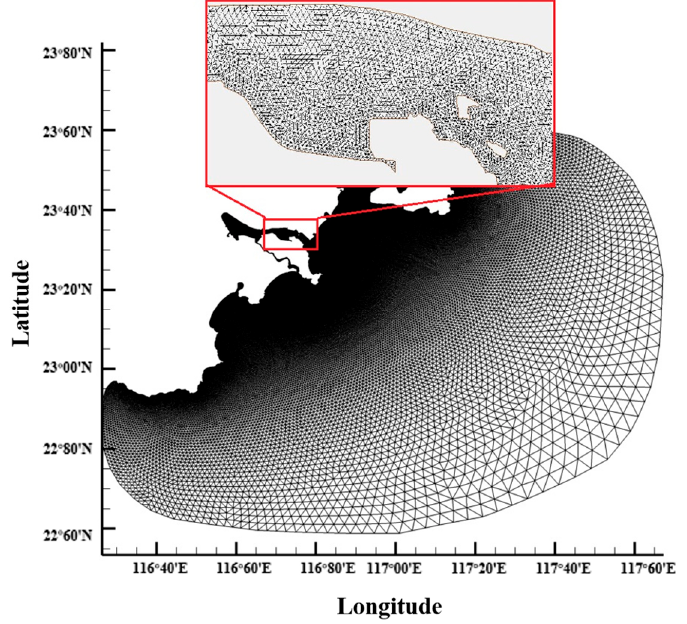
Figure 3. Grid setting in Shantou offshore (the red box in the figure is the coastal area of Shantou City where the grid resolution is up to 100 m).